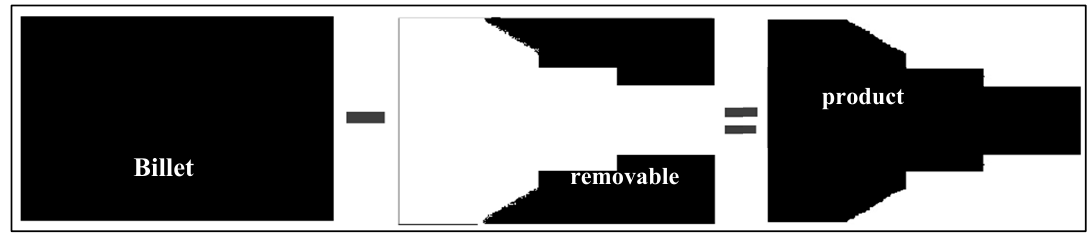
Figure 11. Conceptual demonstration of image subtraction technique for turning the process.